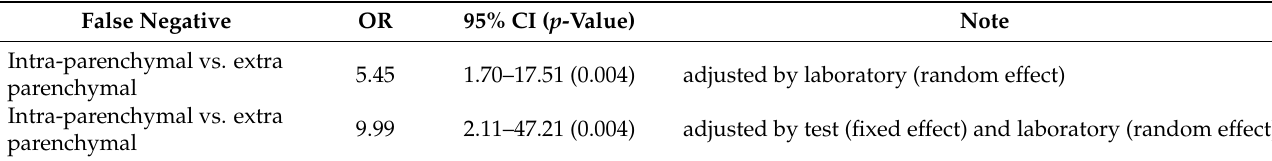
Table 9. Odds Ratio (OR) of the intra-parenchymal versus extra-parenchymal cysts on the serological results of the first Ring